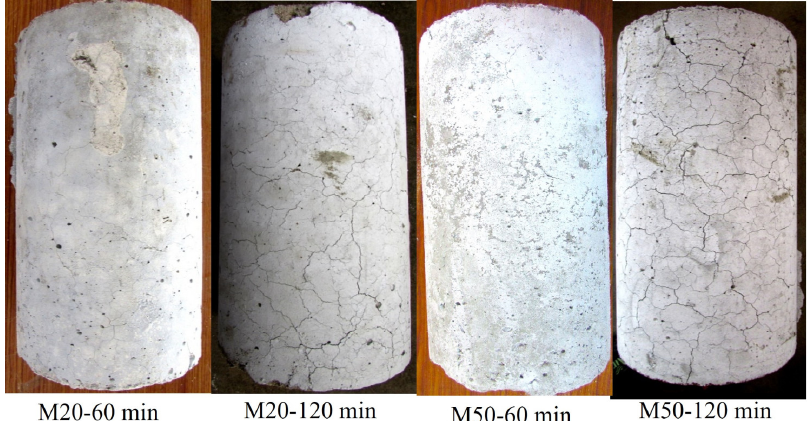
Figure 10. Surface change in concrete specimens exposed to elevated temperatures.